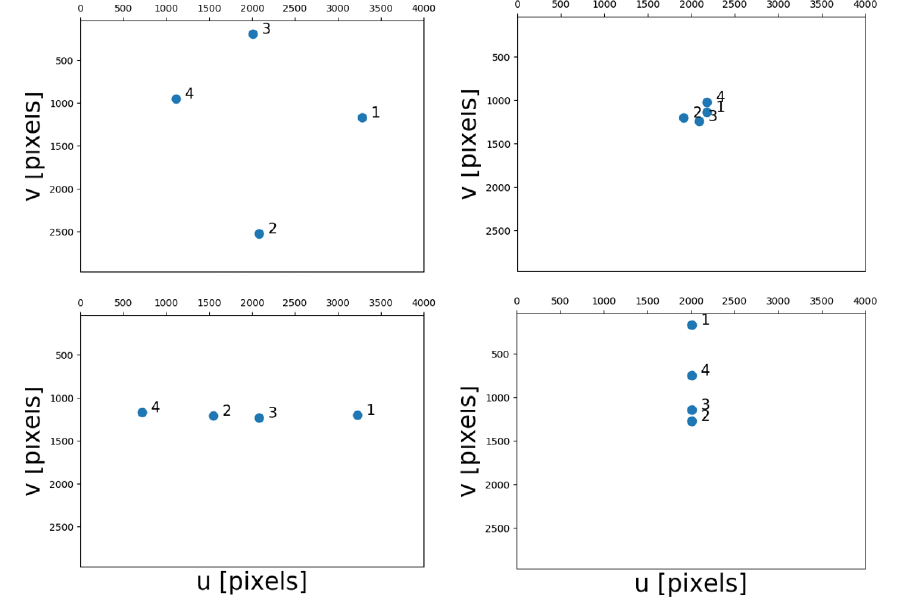
Figure 4. Geometry of 4 selected features in the image plane of four scenarios, with the origin of the image plane at top left. Top left: normal, top right: cluster, bottom left: line up in x, bottom right: line up in